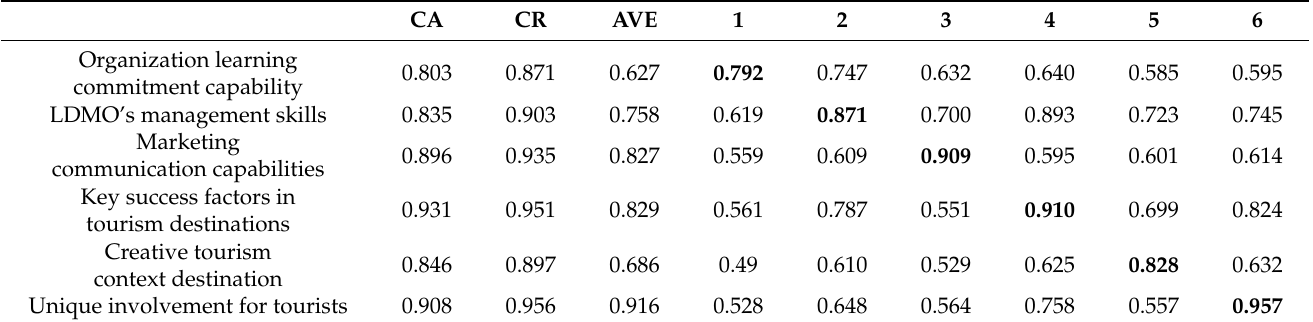
Table 1. Cronbach alpha, composite reliability, average variance, correlations, and discriminant validity.